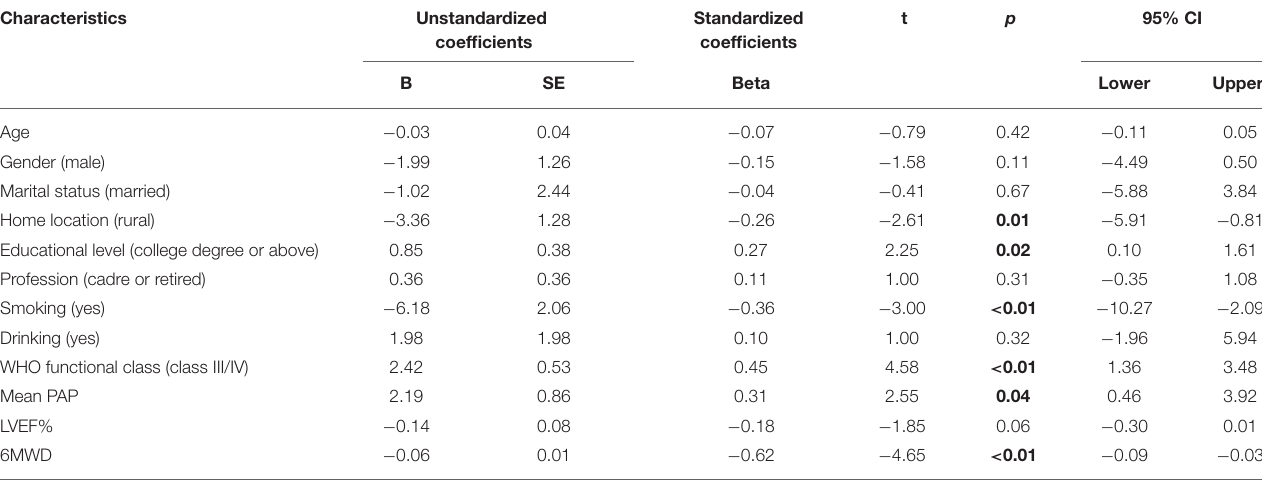
TABLE 4 | Multiple linear regression analysis of depression scores and general